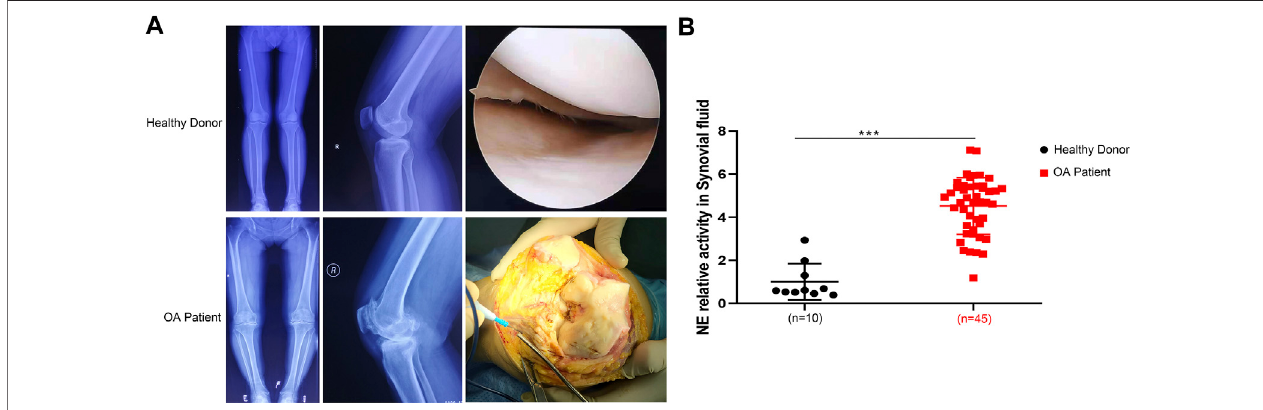
FIGURE 1 | Neutrophil elastase is overexpressed in OA patients. (A) X ray images and macroscopic views (arthroscopic image and intraoperative image) of knee jointfromhealthydonorsandOApatients. (B) NErelativeactivityinsynovial fl uidofhealthydonorsandOApatients.Dataaremean ± SEM; n (cid:1) 10(healthydonors), n (cid:1) 45 (OA patients). *** p < 0.001.